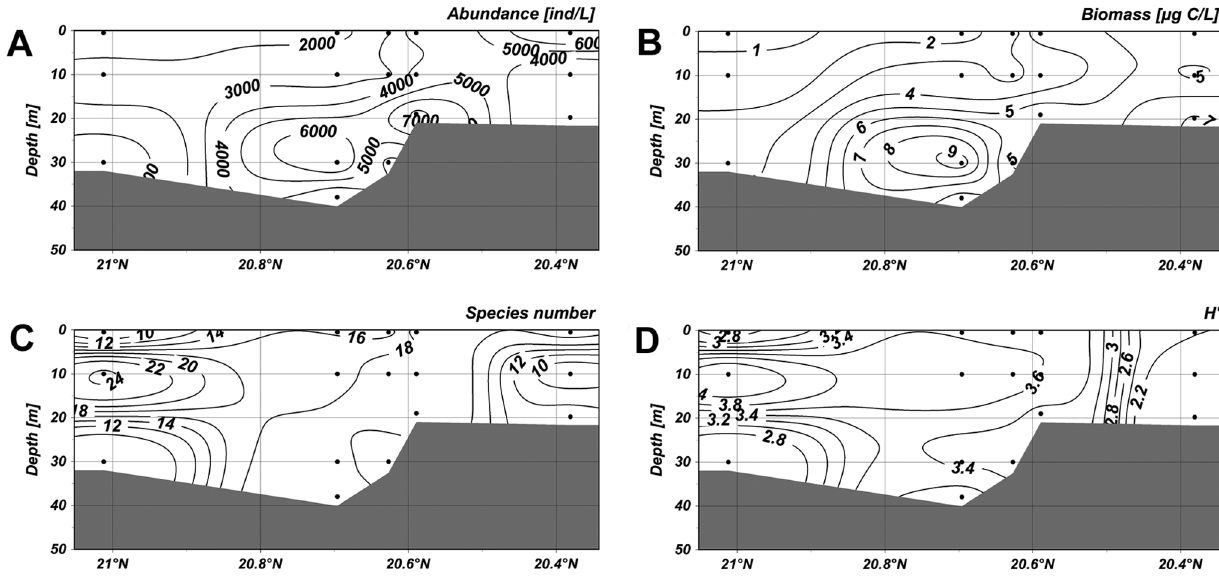
Figure 8. Vertical distribution of planktonic ciliates in the section 3–20. (A) Vertical distribution of abundance. (B) Vertical distribution of biomass. (C) Vertical distribution of species number. (D) Vertical distribution of diversity. The horizontal axis and vertical axis expressed the gradients in latitude and water depth, respectively. (TIFF).